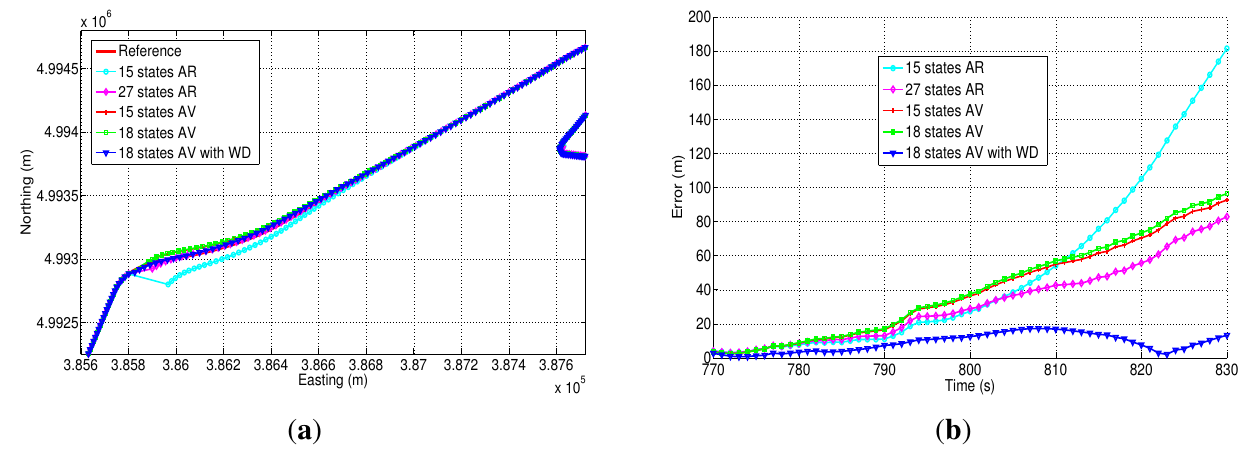
Table 10. Maximum and mean horizontal position error during GPS outages for trajectory